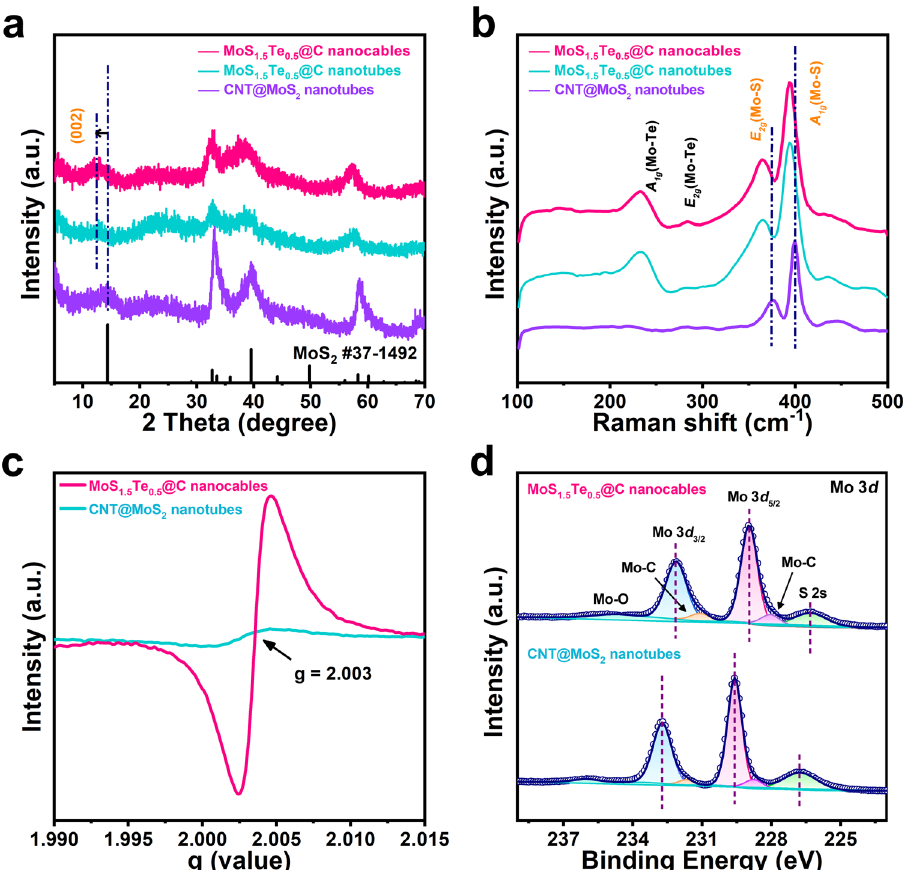
Fig. 2 Characterization of the Mo-containing active materials. a XRD pattern, b Raman spectra, and c EPR results for the Mo-containing active materials. d High-resolution XPS spectrum of Mo 3 d for the MoS 1.5 Te 0.5 @C nanocable and CNT@MoS 2 nanotube